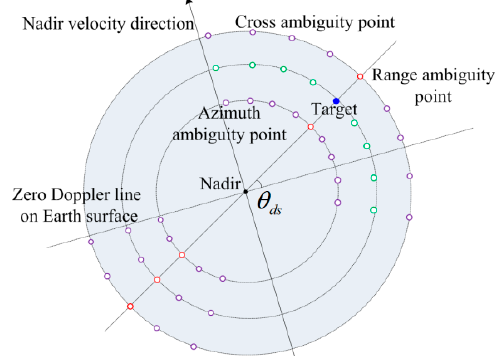
Figure 11. Signal and ambiguity point distribution.